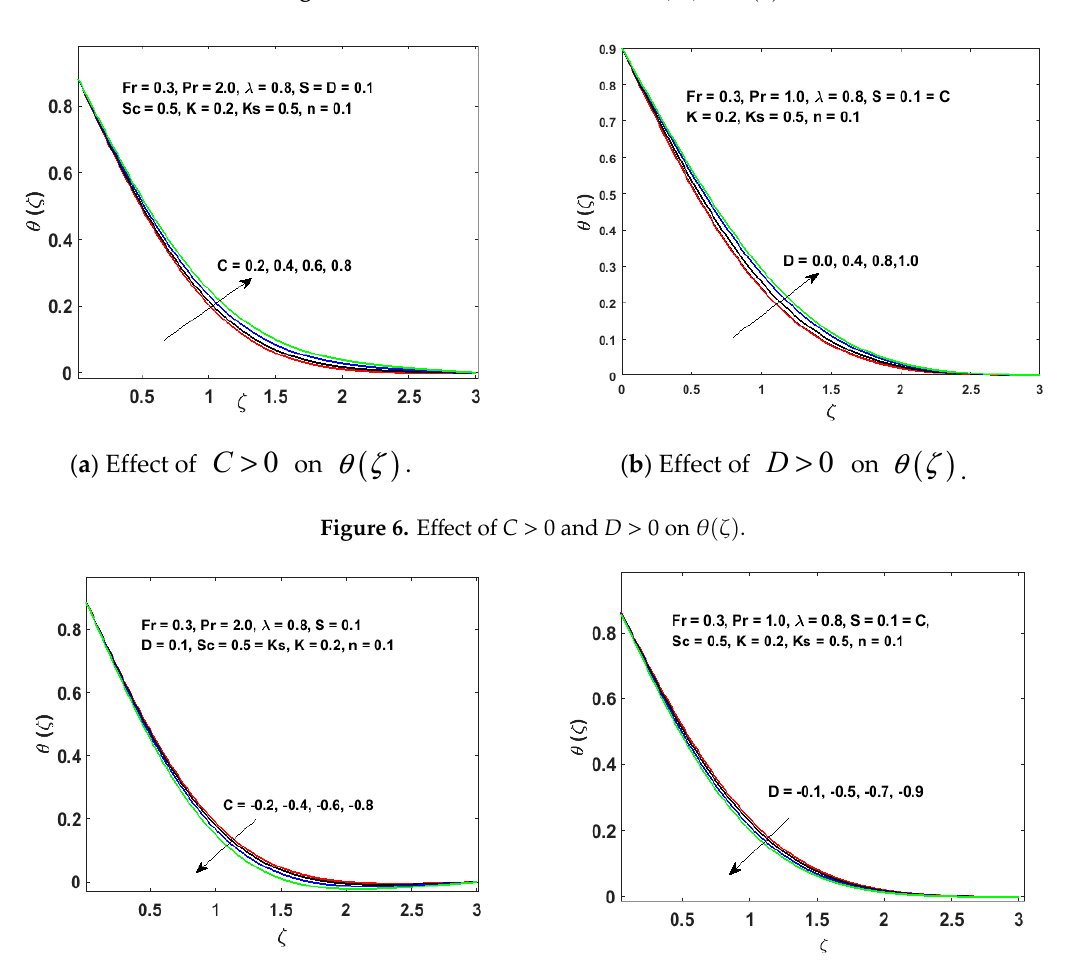
Figure 5. Effect of the Prandtl number ( Pr ) on